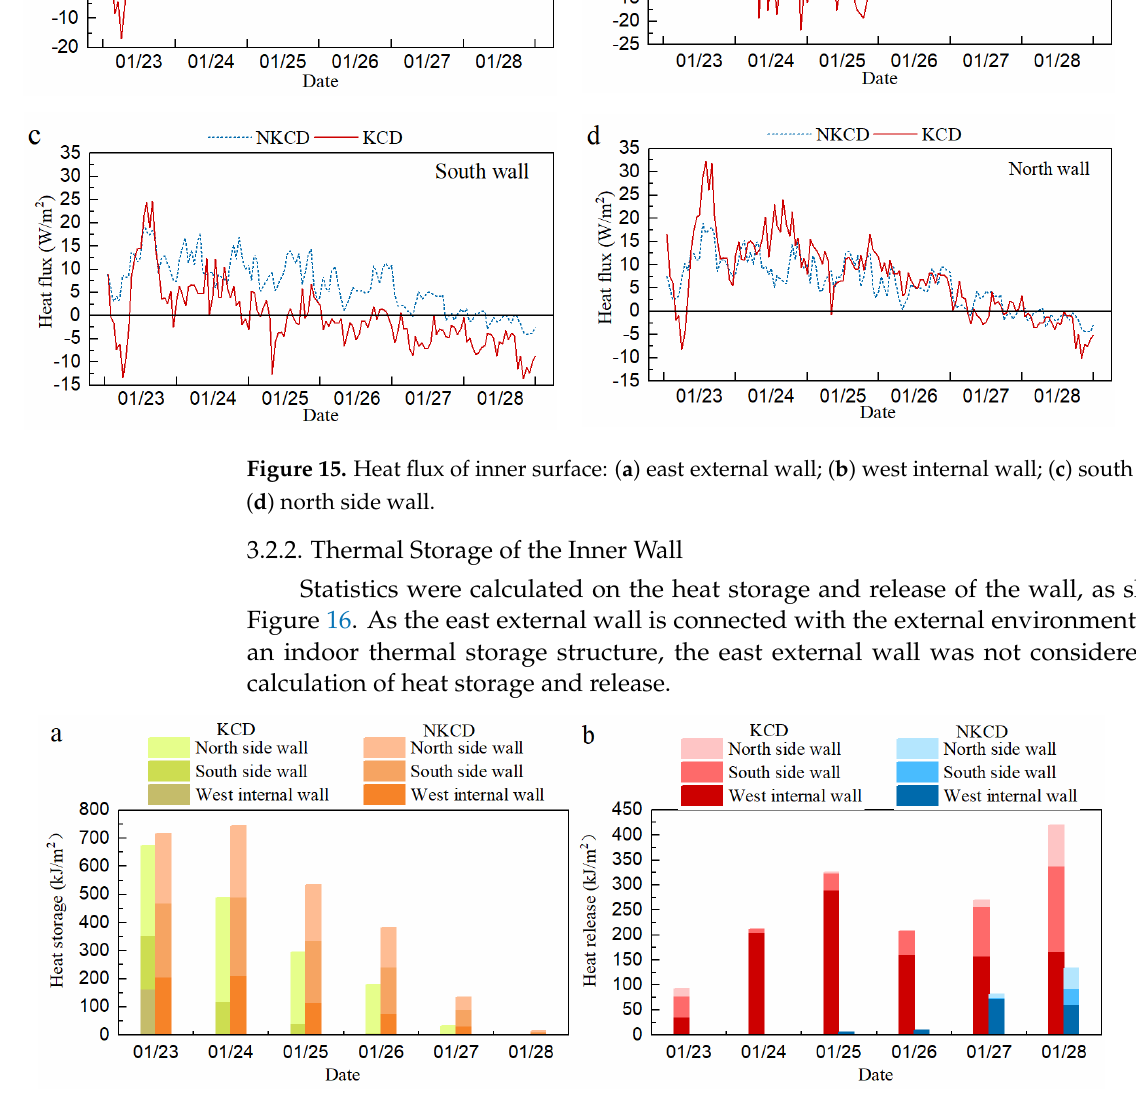
Figure 16. ( a ) Heat storage of the inner wall; ( b ) heat release of the inner